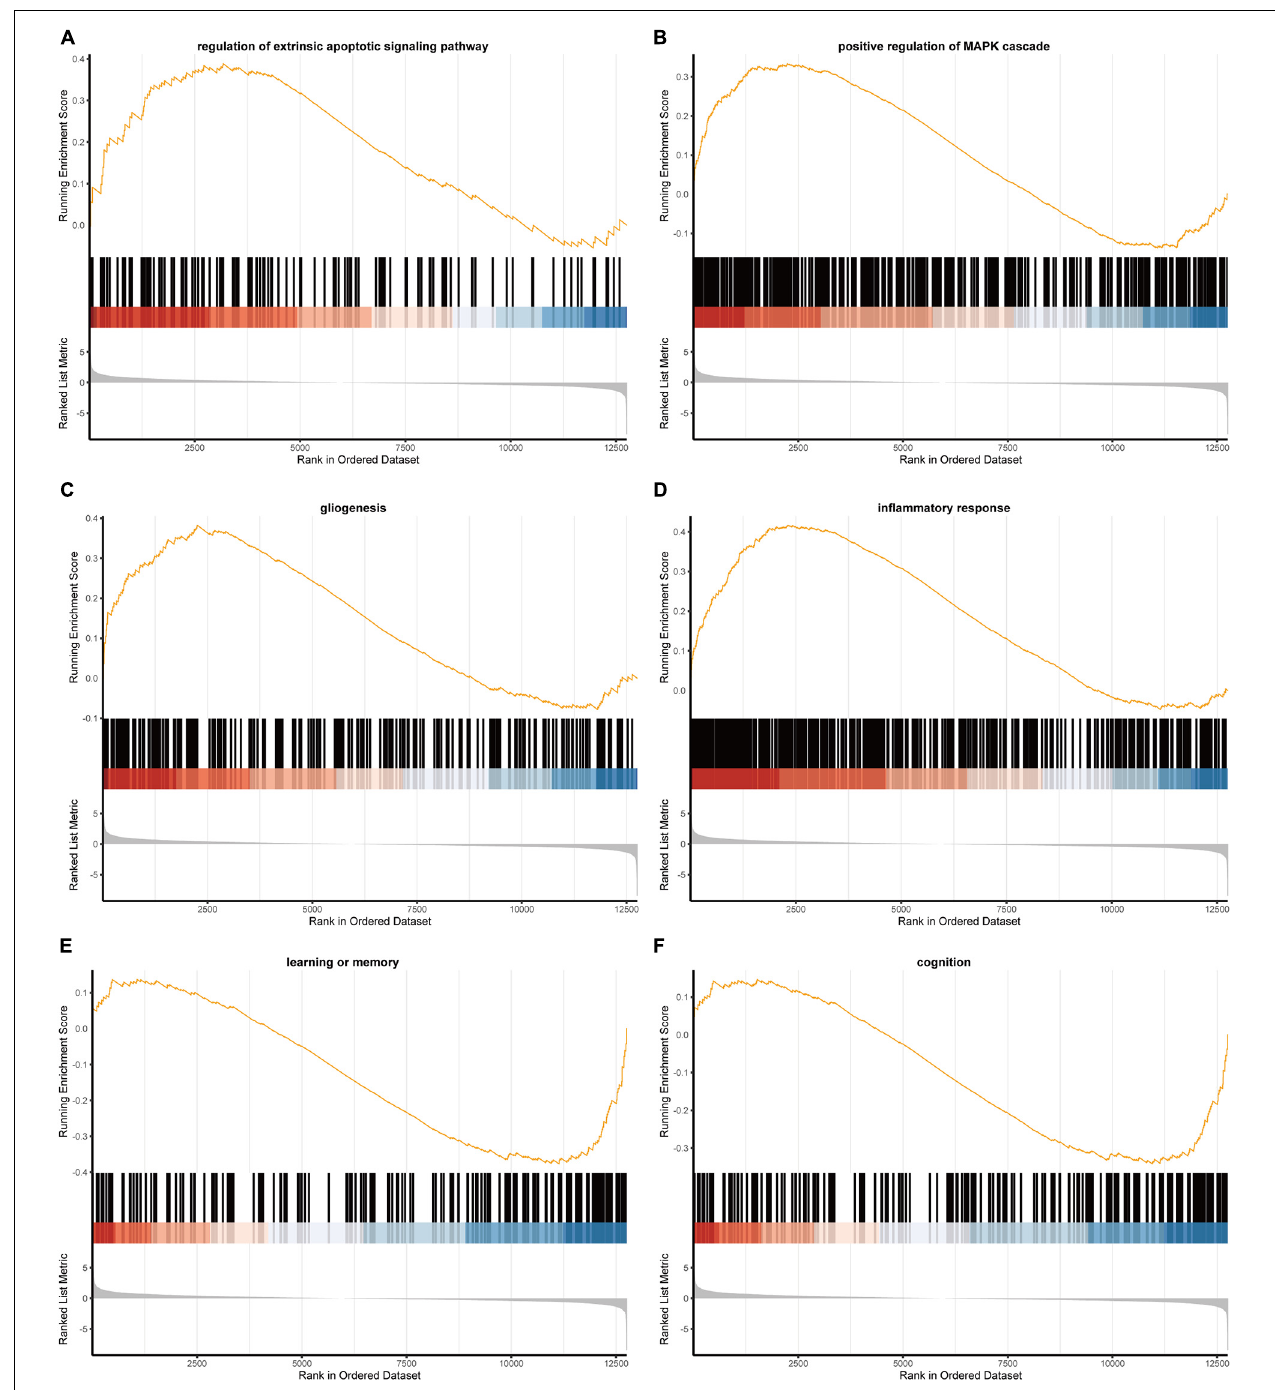
FIGURE 3 | The GSEA results of mRNAs. (A) Regulation of extrinsic apoptotic signaling pathway; (B) positive regulation of MAPK cascade; (C) gliogenesis; (D) inflammatory response; (E) learning or memory; (F) cognition.